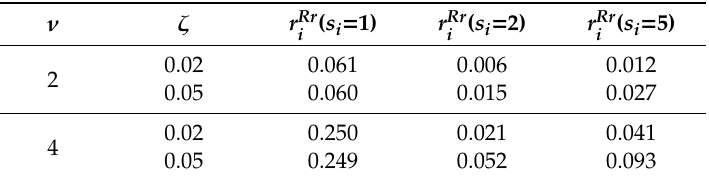
for di ff erent ν , ζ and s i i